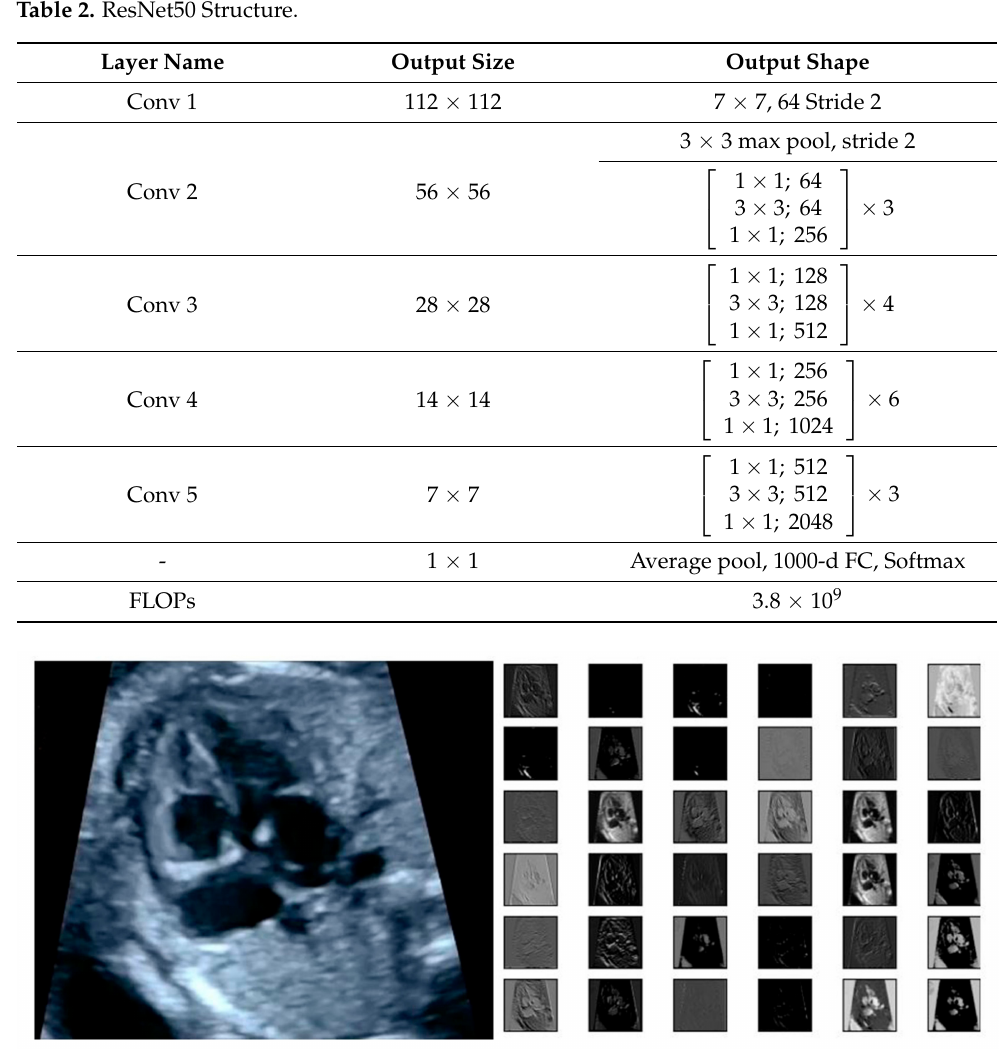
Figure 7. The example of feature map extracted from ResNet50 architecture in the RPNs back bone. Mask-RCNN adds learning process for segmentation masks in each RoI. The segmen- tation process is simultaneous with each of the other processes (bounding box regression and class generation), using convolution arrays (feature map) from RPNs. The RPNs classify the feature and tighten bounding boxes with region of interest (RoI) alignment (RoIAlign). The hyperparameters used in the RPNs’ structure are batch size for each image of 256; learning rate of 0.001; momentum of 0.9; non-maximum suppression threshold of about 0.7; intersection over union (IoU) baseline of 0.5; and anchor sizes of 32, 64, 128, 256, and 512. RoI alignment was performed to pool all RoIs remaining on the feature